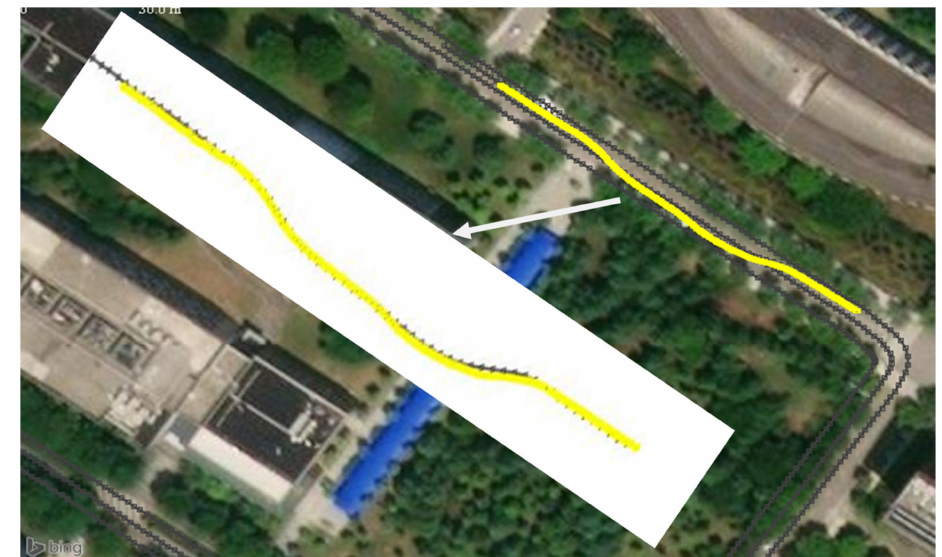
Figure 16. The tracking trajectory and global positioning system (GPS) trajectory in an high-definition (HD) map. The yellow line indicates the tracking result using the proposed algorithm, and the gray line is the measurements of the GPS